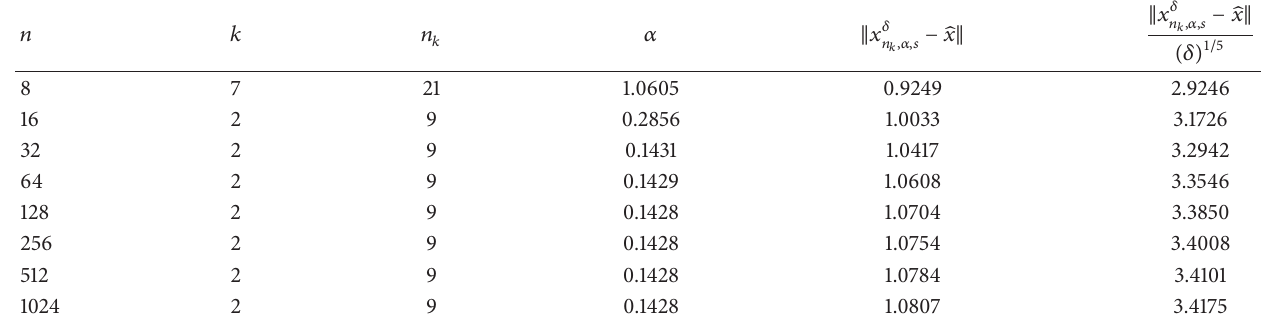
Table 2: Iterations and corresponding error estimates with 𝛿 = 1.8𝐸 − 5 , 𝜎 = 0.1